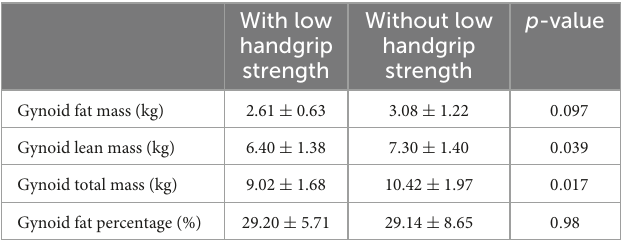
TABLE 9 Comparison of gynoid total mass, lean mass, and fat mass in participants with and without low handgrip